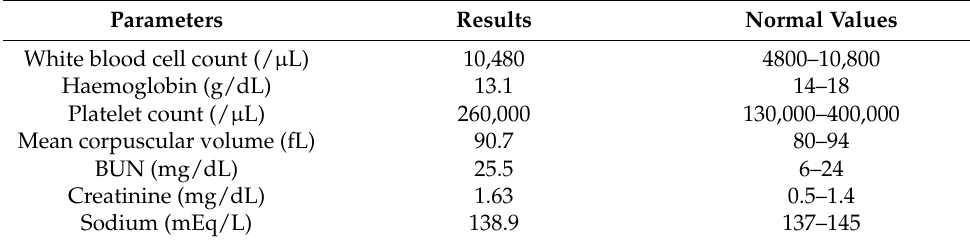
Table 1. Blood biochemistry